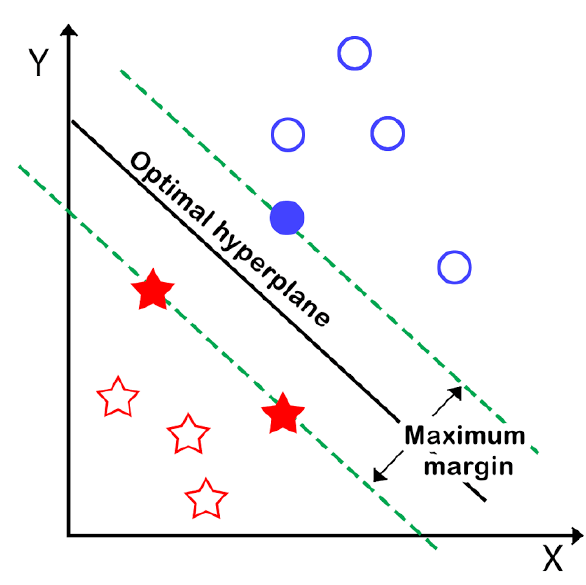
Figure 19. Representation of Support vector machine [15].